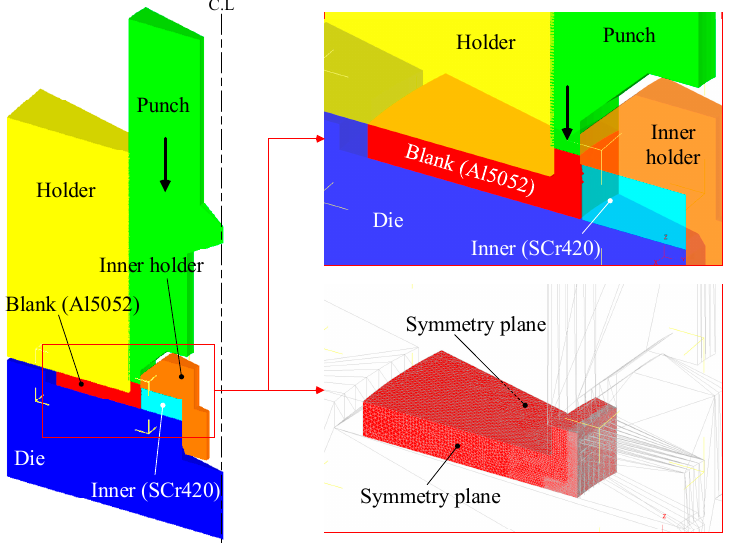
Figure 5. Initial finite element (FE) analysis model.